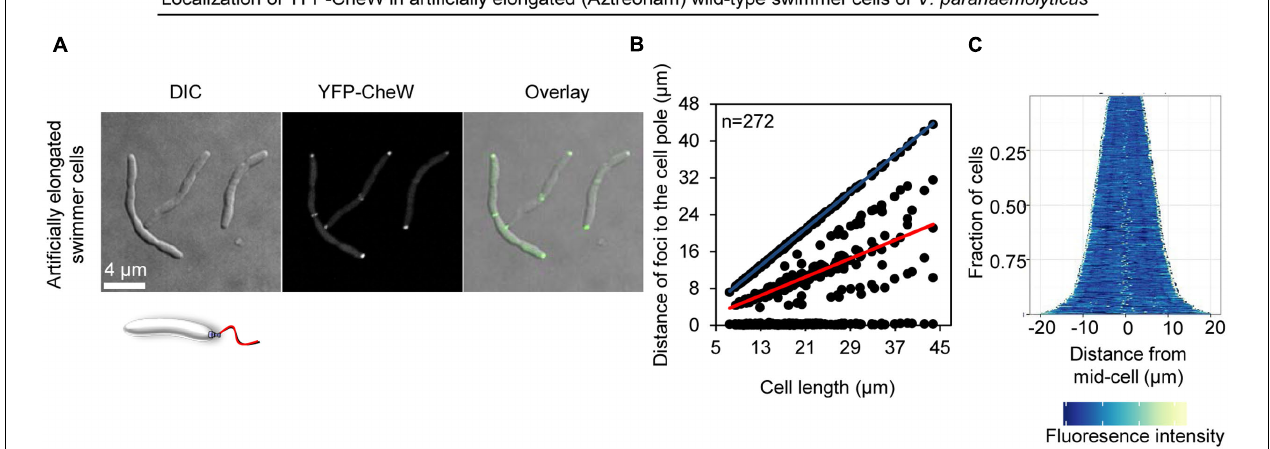
FIGURE 5 | The intracellular formation of chemotactic signaling arrays is cell type specific and not a consequence of swarm cell elongation. Intracellular localization of YFP-CheW in wild-type swimmer cells of V. parahaemolyticus treated with the antibiotic Aztreonam in order to artificially induce elongation of swimmer cells. (A) Microscopy showing the intracellular localization of YFP-CheW. (B) Graph depicting the distance of YFP-CheW foci from the cell poles as a function of cell. (C) Demographic analysis showing the fluorescence intensity of YFP-CheW along the cell length in a population of V. parahaemolyticus cells relative to cell